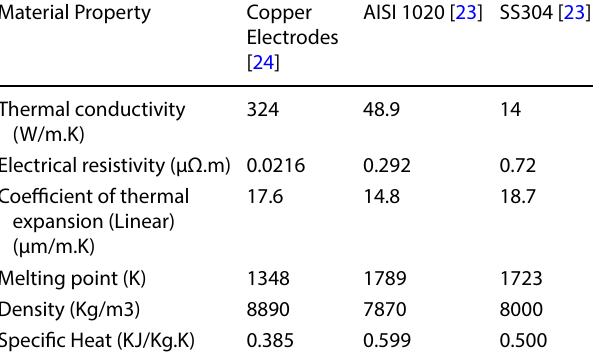
Table 6 Material Properties for numerical simulation Material Property Copper Electrodes